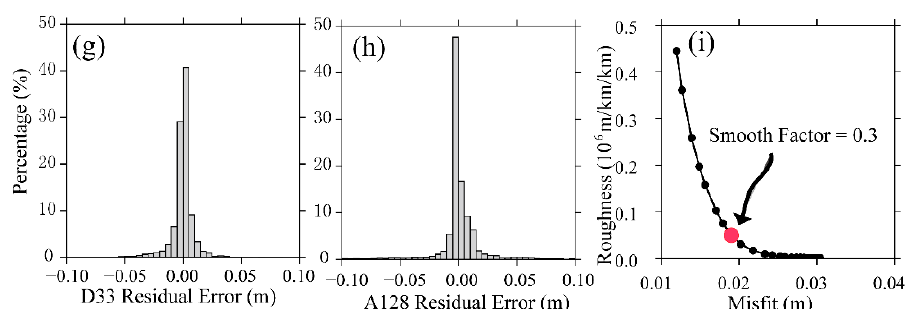
Figure 7. Data fitting and residual error statistics for the optimal coseismic model. The ( a ) original observations, ( b ) predicted values, and ( c ) residual errors for the D033 and ( d – f ) A128 orbits, respec- tively. ( g ) Statistical distribution of the residual error for the D033 and ( h ) A128 orbits. ( i ) L-curve showing the selected smooth-factor used in the coseismic inversion model.